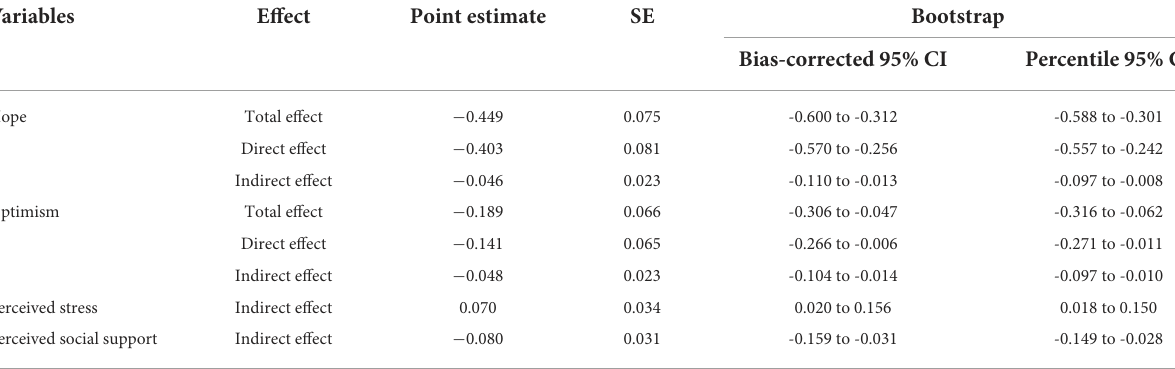
TABLE 6 The mediating effect of resilience between various psychological variables and